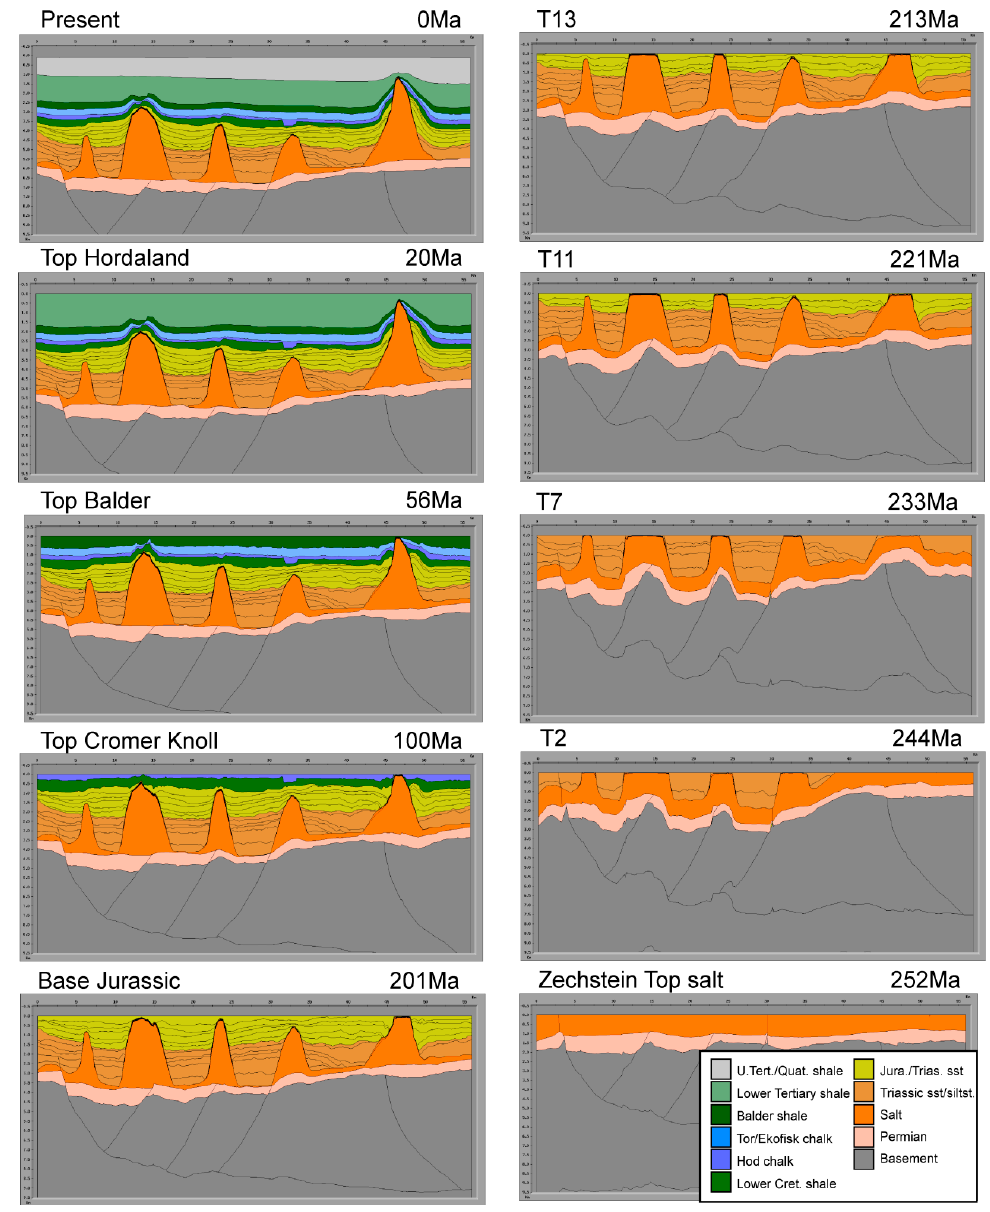
Figure 14. Geohistory reconstruction of Model 2. The figure shows 10 of the total 24 time-steps in the model, including 14 time steps during Triassic